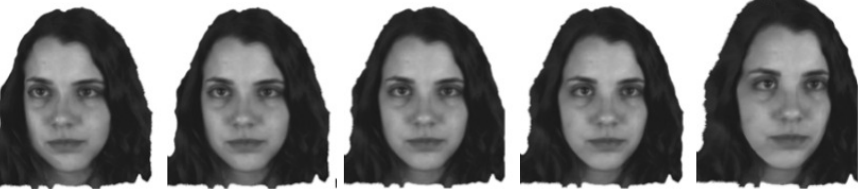
Figure 22. Example views generated for